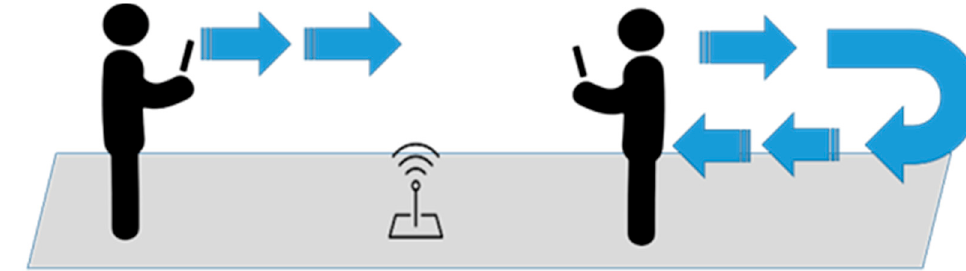
Figure 12. The process of measuring the responsiveness. Table 3. The results of responsiveness